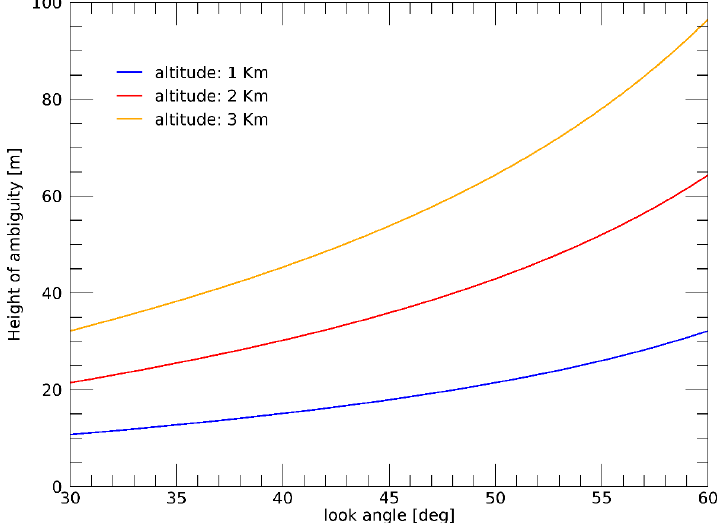
Figure 3. Height of ambiguity of the AXIS system versus the look angle for three different flight altitudes.